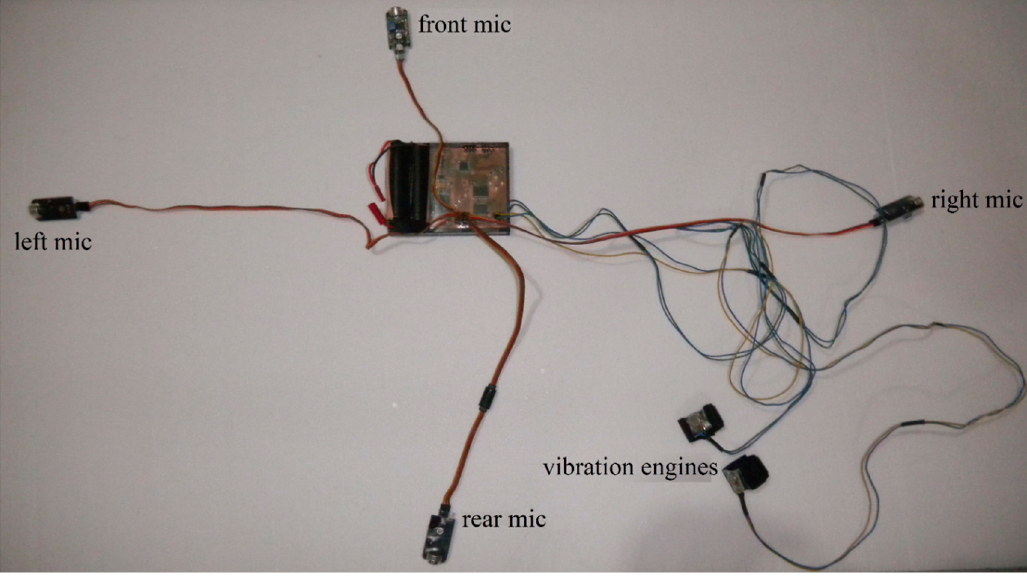
Figure 3. The developed wearable system.